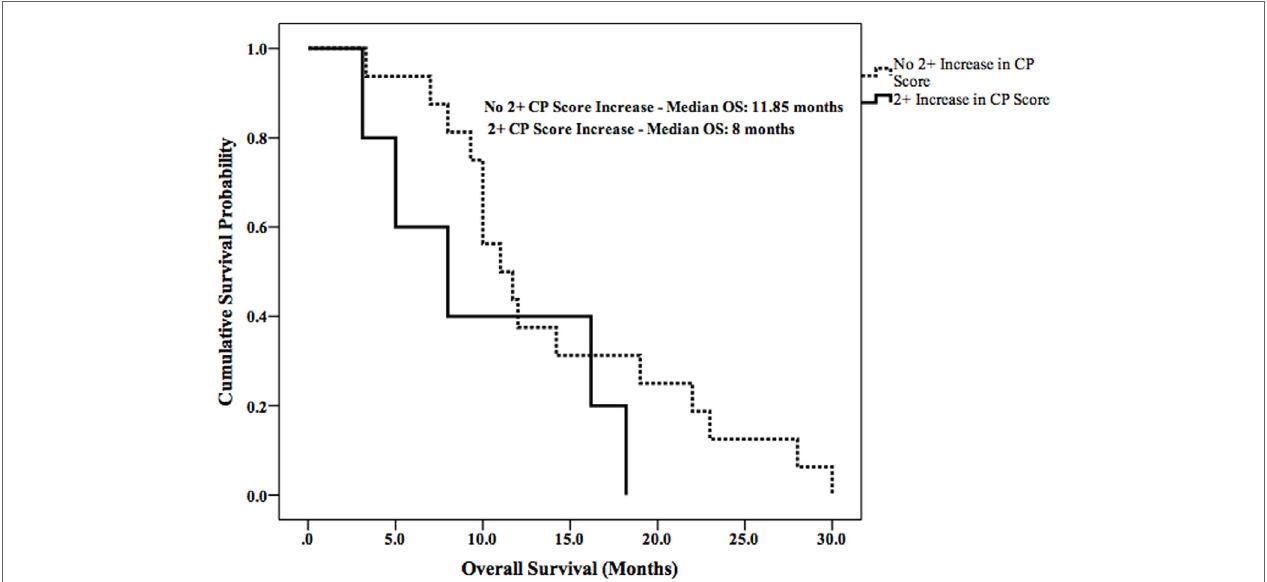
FigUre 4 | Kaplan–Meier curves comparing Os in patients with or without a 2 + increase in cP score .